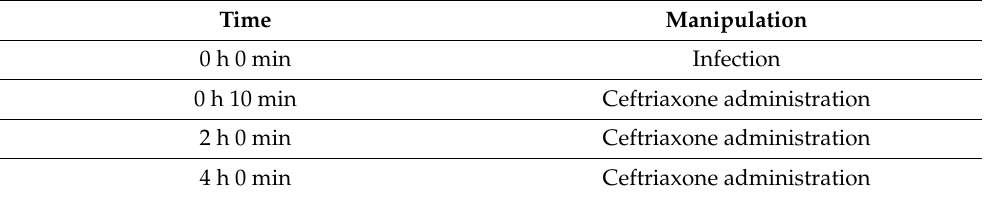
Table 8. Infection–treatment manipulations with the mice of IP group.